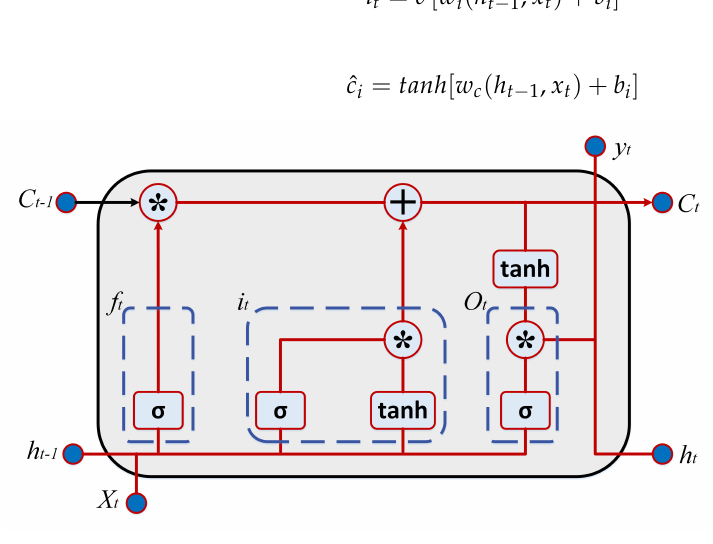
Figure 2. The typical structure of LSTM